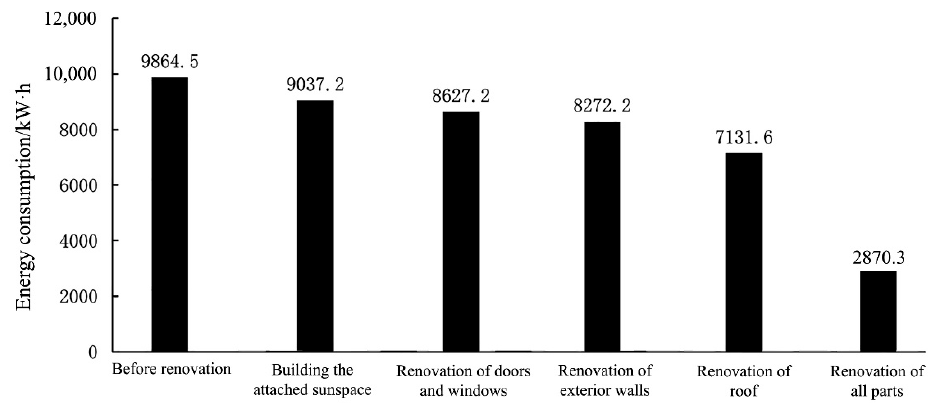
Figure 24. Effects of different renovation measures on heat energy consumption.